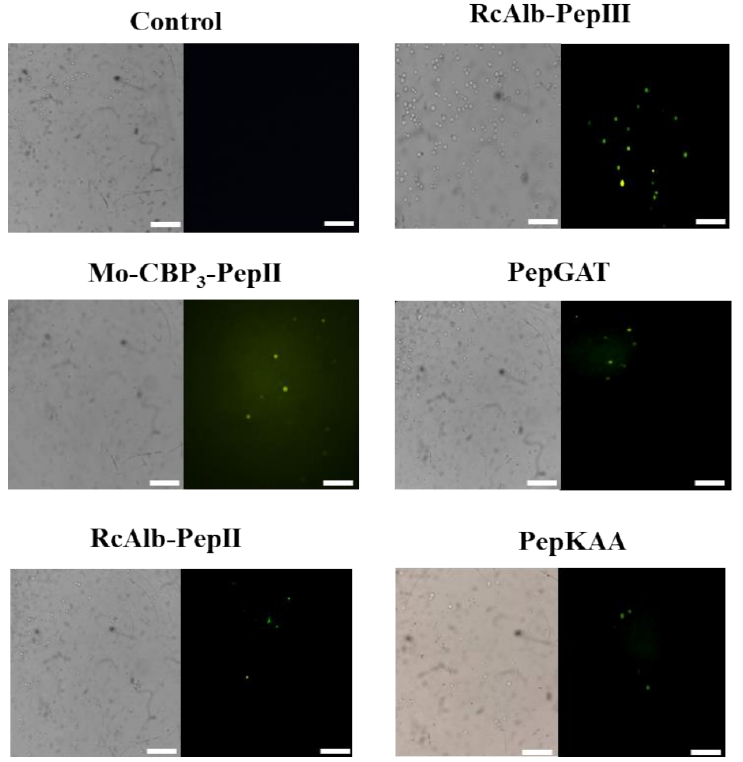
Figure 5. Apoptosis induction in C. neoformans cells by Mo -CBP 3 -PepII, Rc Alb-PepII, Rc Alb-PepIII, PepGAT, and PepKAA, respectively, at 25, 0.04, 0.04, 0.04, and 0.04 µg mL − 1 . Green fluorescence images show that treatment with the peptides (MIC 50 ) activates caspases involved in programmed cell death. Control: DMSO-NaCl. Bars: 100 µm.